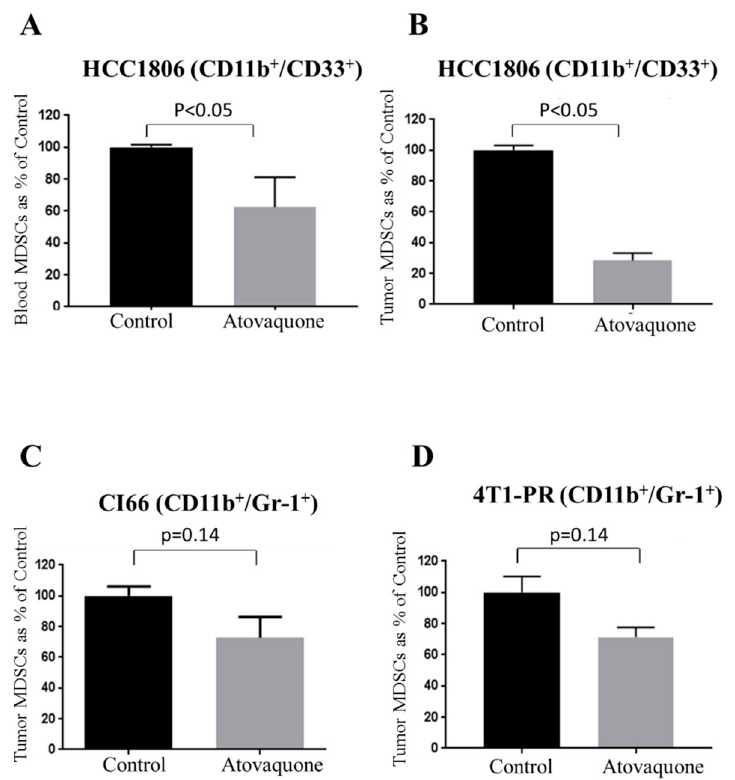
Figure 2. Effect of Atovaquone on MDSCs. Peripheral blood mononuclear cells (PBMCs) were collected from the blood obtained from HCC1806 tumor-bearing mice. ( A ) Bar chart representing percent MDSCs which were stained with CD11b and CD33 human antibodies; n = 4. Tumors from control and atovaquone-treated group in all three in vivo experiments were isolated, processed and suspended into single-cell suspension with the help of gentle MACS dissociator using tumor dissociator kit. Percentage of MDSCs from ( B ) HCC1806 tumor cells (stained with CD11b/CD33 human antibodies); n = 3 ( C ) CI66 tumors (stained with CD11b/Gr-1 mouse antibodies); n = 3 and ( D ) 4T1-PR tumors (stained with CD11b/Gr-1 mouse antibodies); n = 3. Data shown as mean ± SEM. A p -value less than 0.05 was considered to be significant.